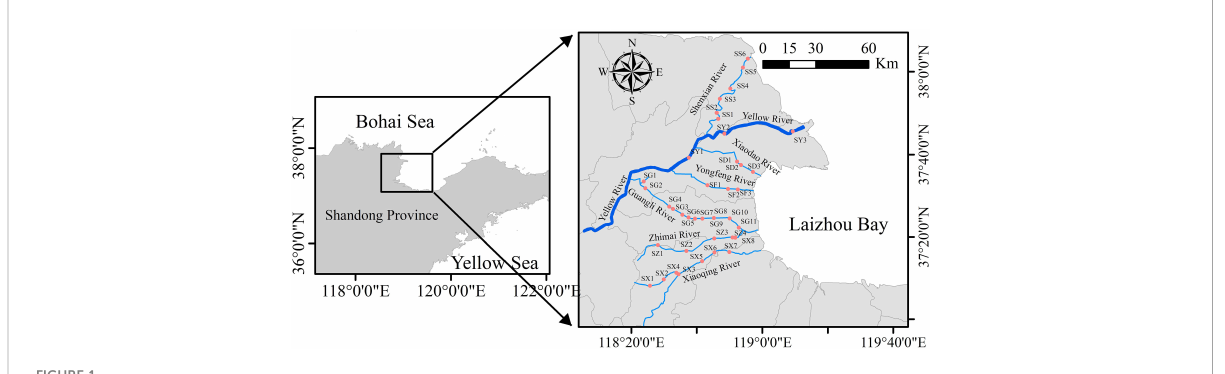
FIGURE 1 Location map of sampling stations in seaward rivers in the Yellow River Delta. The blue dots indicate sampling sites, and the blue line represents the